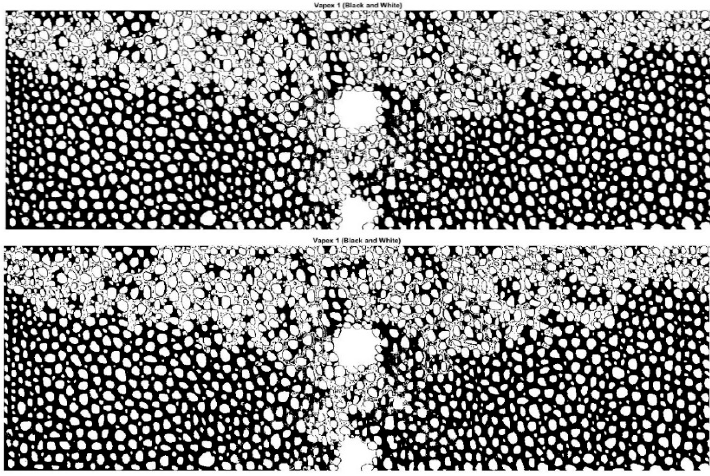
Figure 5. The IA analysis for conventional and a pattern with horizontal fractures.